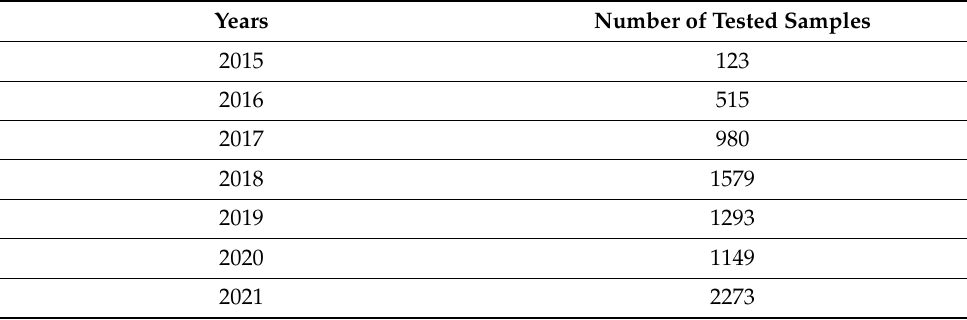
Table 1. Number of tested human serum samples per year between 2015 and 2021.